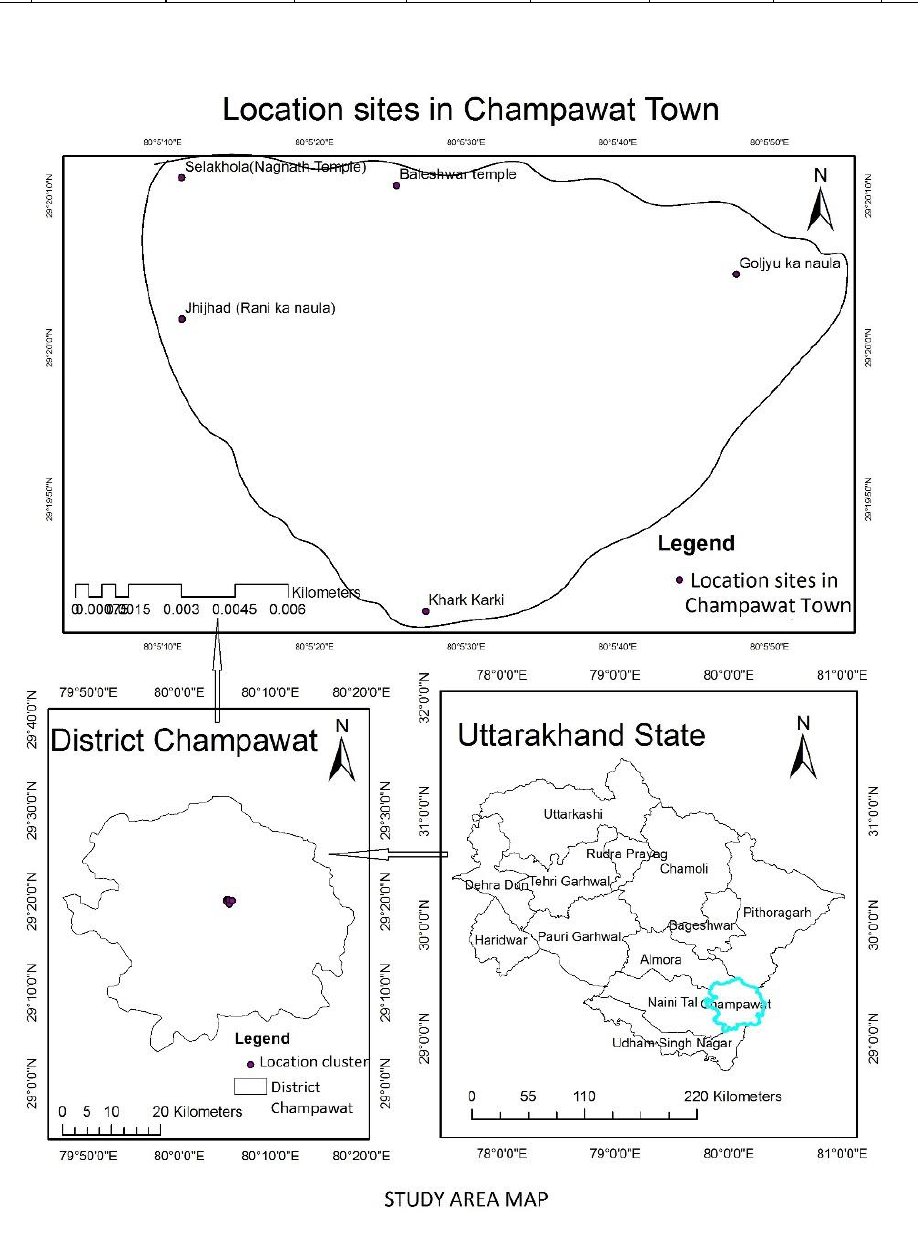
Figure 1. Map representing the sampling